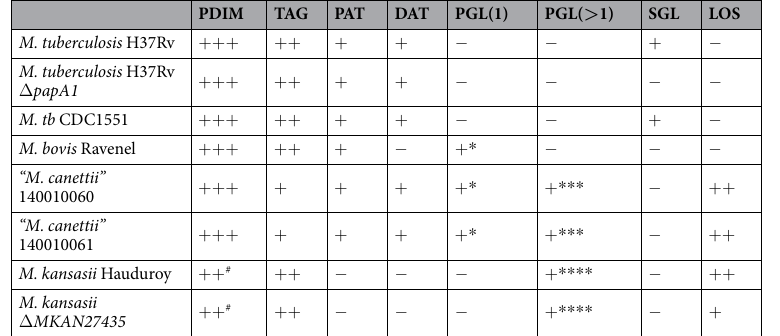
Table 1. Distribution of cell envelope lipids in test strains. Abbreviations: PDIM, dimycocerosates of phthiocerol A, phthiocerol B and phthiodiolone ( ++ # Indicates phthiodiolone); TAG, triacylglycerols; PAT & DAT, penta- and diacyl trehaloses; PGL(1), single sugar phenolic glycolipid ( + * ); PGL( > 1), multiple